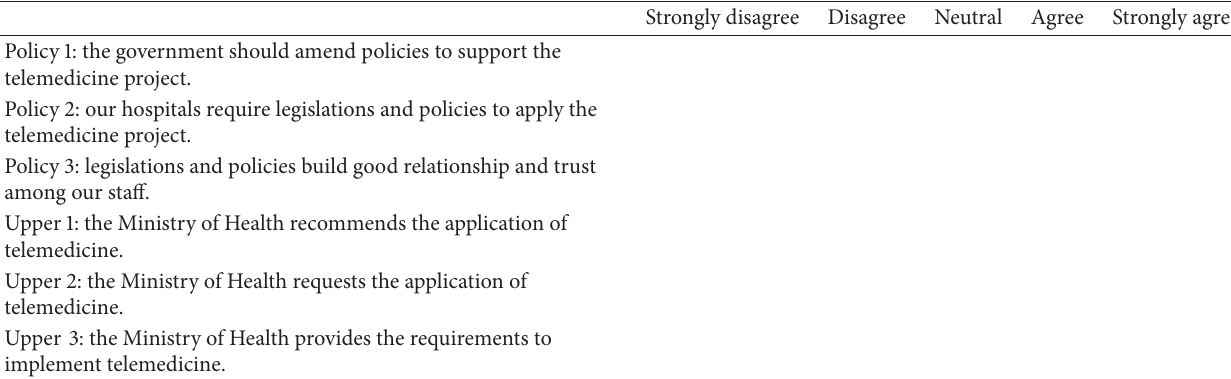
Table 8: Part 6: environmental